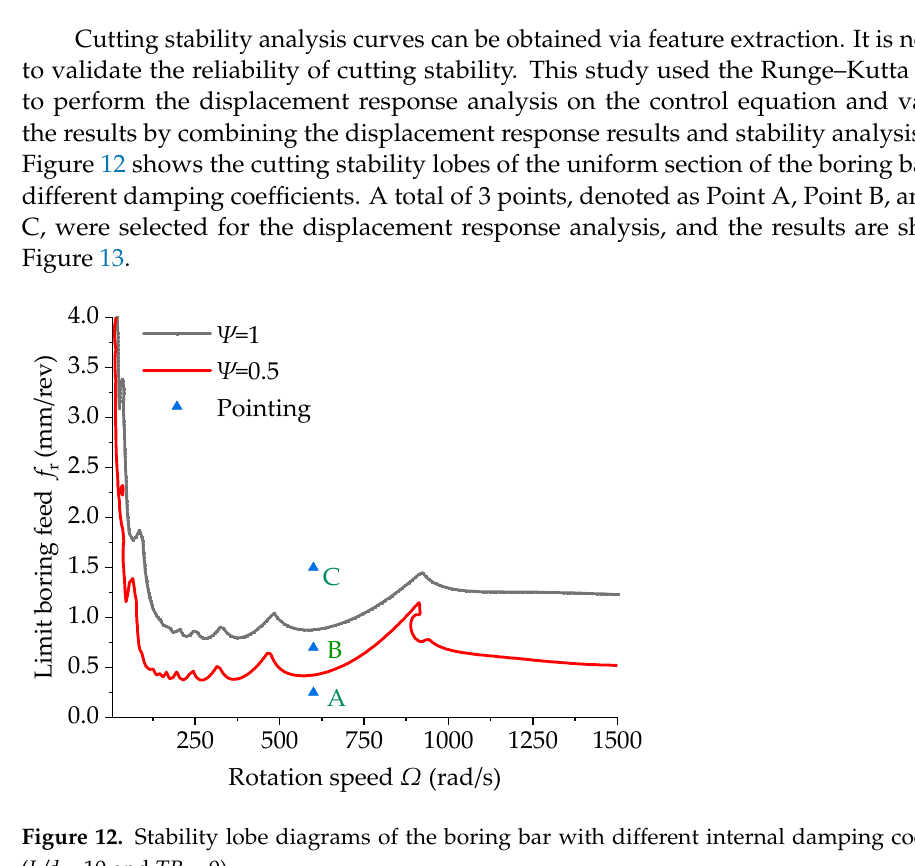
Table 4. Rotation speeds and cutting depths of the different points in Figure 11. Point